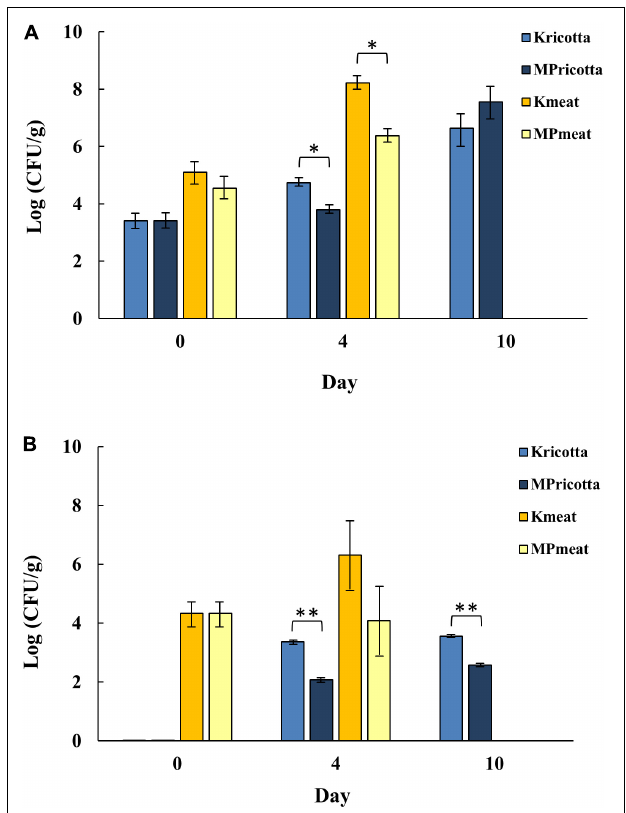
FIGURE 3 | Evolution of (A) aerobic plate count (APC) and (B) yeast counts of ricotta cheese and meat, treated with MTP1-PETs (MP) during different days. Not-functionalized PETs were used as control (K). Data are presented as means ± s.d. of five different samples analyzed in triplicate. ∗ , Significant difference ( p < 0.05) between the treated and the control samples; ∗∗ , Significant difference ( p < 0.01) between the treated and the control samples.